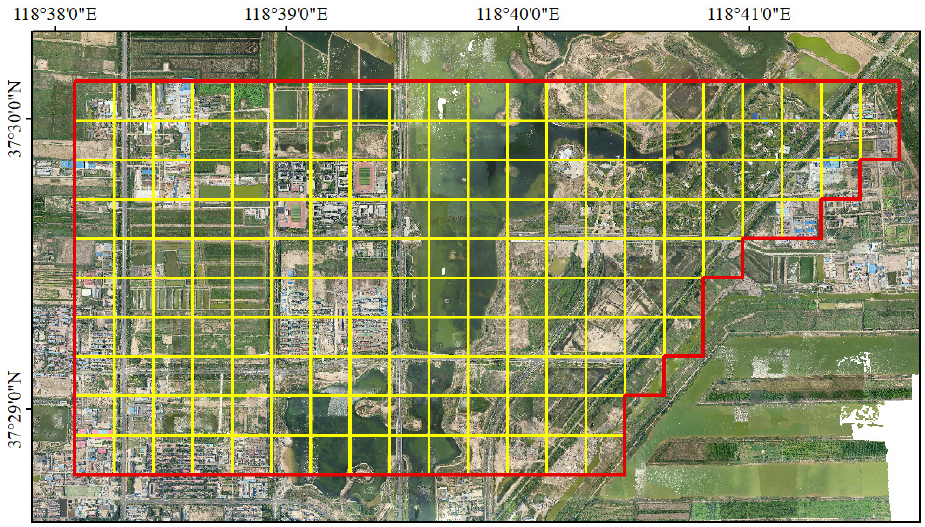
Figure 10. Experimental area.